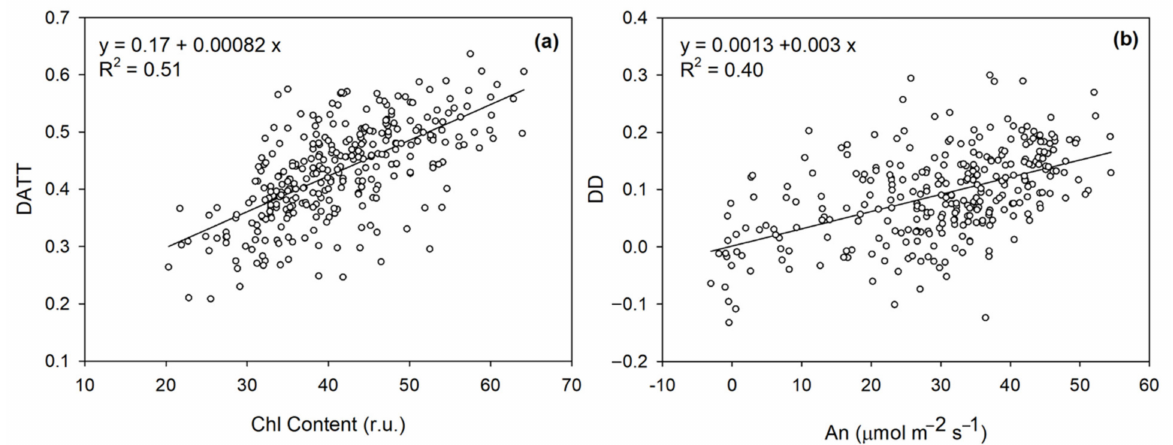
Figure 6. The linear regression parameters between the ( a ) DATT index and leaf chlorophyll content (Chl content); ( b ) DD index, and net assimilation rate